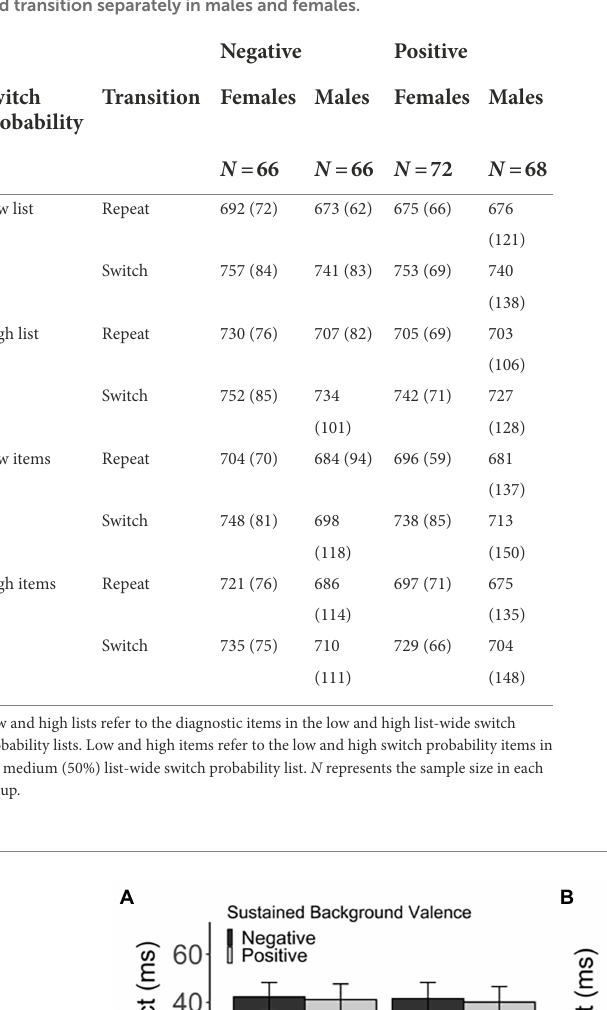
TABLE 3 Mean response times (ms) with standard deviations in Experiment 1 as a function of background valence, switch probability, and transition separately in males and